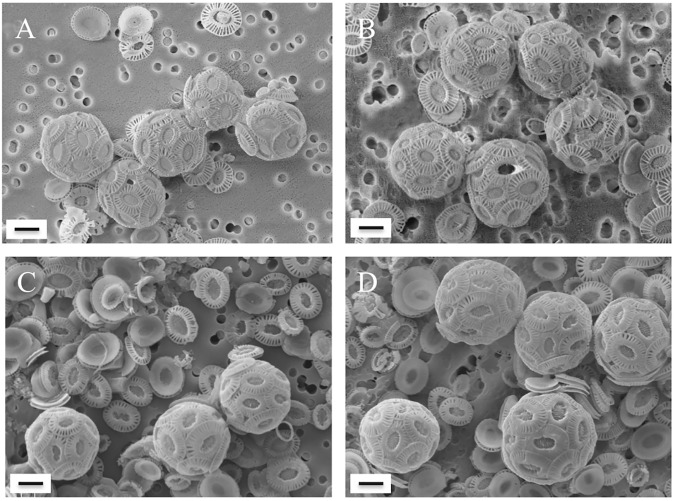
Scanning electron microscopy images of E. huxleyi CCMP 88E (A, B) and NZEH (C, D) after incubations in water collected from 1,000 m (A, C) and 4,800 m (B, D). Scale bar: 2 μm.